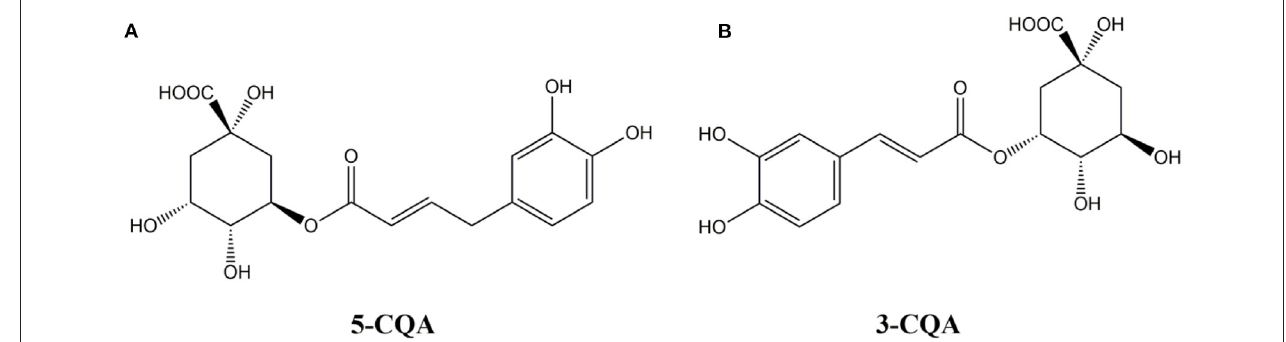
FIGURE 1 | Chemical structural formula of (A) 5-CQA and (B)